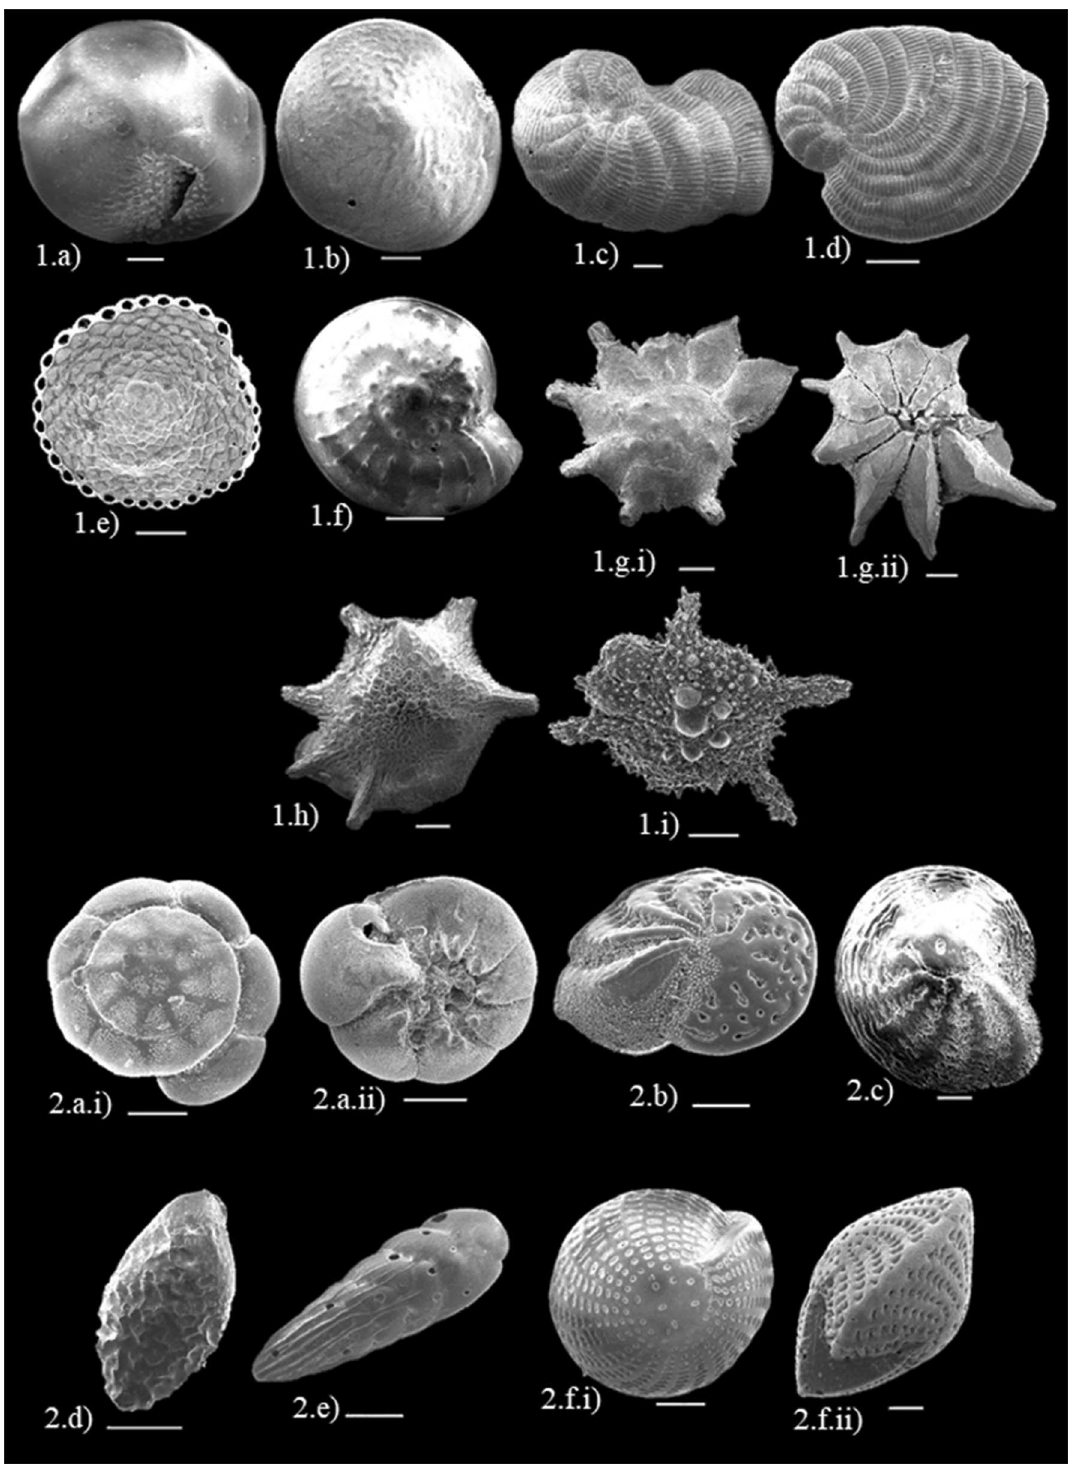
Figure 1. Scanning Electron Micrographs (SEM) of symbiont-bearing genus that possess relatively similar ecological needs as coral reefs. 1.a ) Amphistegina lessonii (100 µm × 110); 1.b ) Amphistegina papillosa (100 µm × 130); 1.c ) Peneroplis pertusus (100 µm × 100); 1.d ) Peneroplis planatus (200 µm × 90); 1.e ) Sorites orbiculus (200 µm × 80); 1.f ) Asillina ammonoides (500 µm × 43); 1.g.i ) Lateral side: Pararotalia domatayi (100 µm × 110); 1.g.ii ) Umbilical side: Pararotalia domatayi (100 µm × 100); 1.h ) Calcarina gaudichaudii (200 µm × 55); 1.i ) Calcarina hispida (200 µm × 80) and Scanning Electron Micrographs (SEM) of opportunist taxa (stress-tolerant)which are more resilient towards ecological changes 2.a.i ) Lateral side: Ammonia tepida (100 µm × 200); 2.a.ii ) Umbilical side: (100 µm × 220); 2.b ) Elphidium crispum (100 µm × 160); 2.c ) Parrelina hispidula (100 µm × 120); 2.d ) Bolivina vadescens (100 µm × 250); 2.e ) Bolivina sabahensis (100 µm × 220); 2.f.i ) Lateral side: Cellanthus craticulatus (200 µm × 90); 2.f.ii ) Edge side: Cellanthus craticulatus (100 µm ×